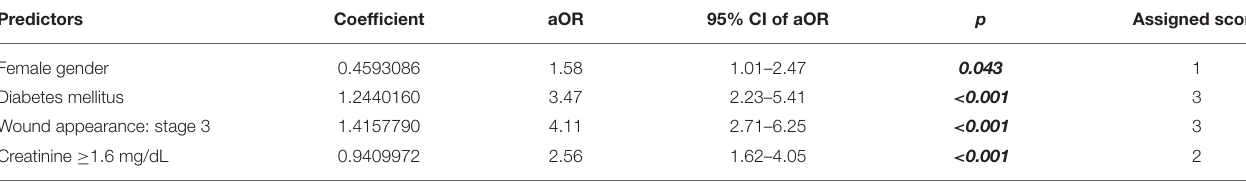
TABLE 3 | Multivariable analysis and risk score for amputation in patients with necrotizing fasciitis. Predictors